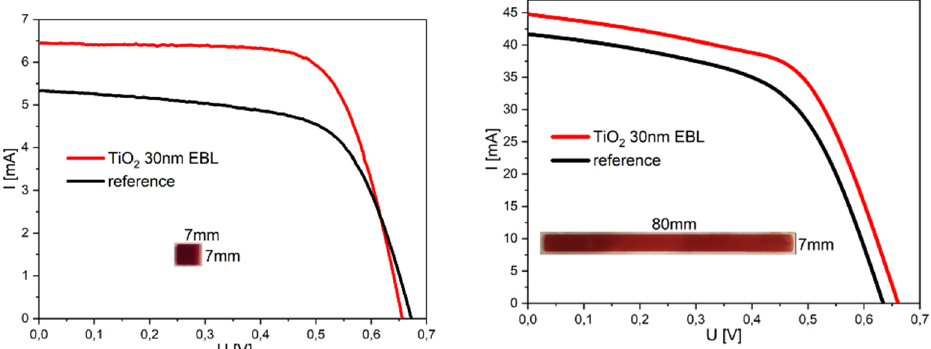
Figure 7. Current–voltage characteristics for 7 × 7 mm 2 and 7 × 80 mm 2 DSSC devices with and without a TiO 2 electron blocking layer.